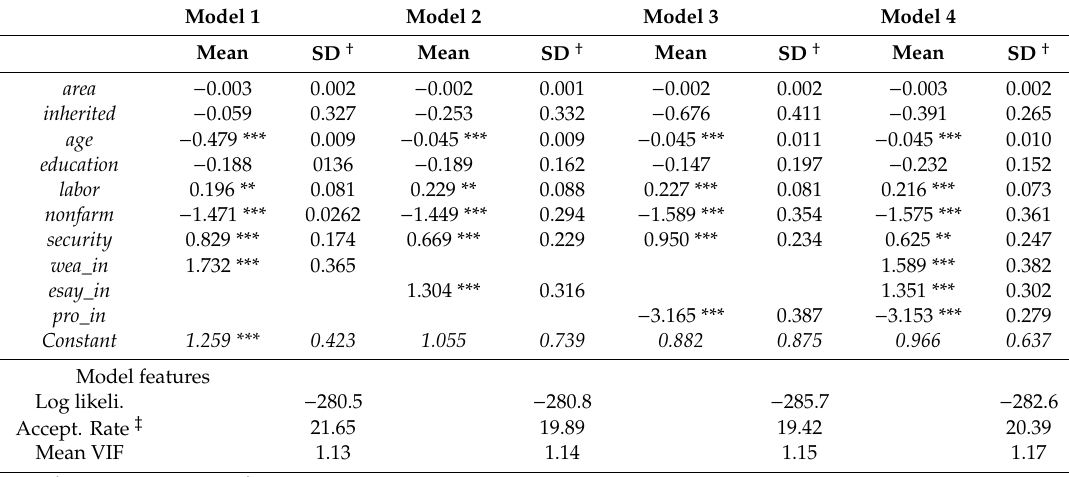
Table 3. Results of factors a ff ecting farmers’ intention of leasing